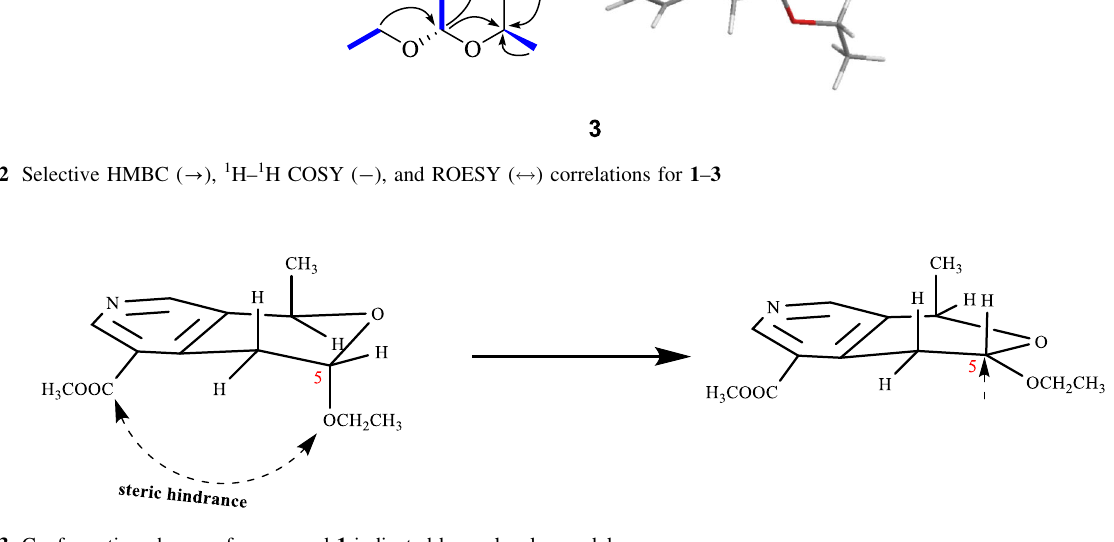
Fig. 3 Conformation change of compound 1 indicated by molecular